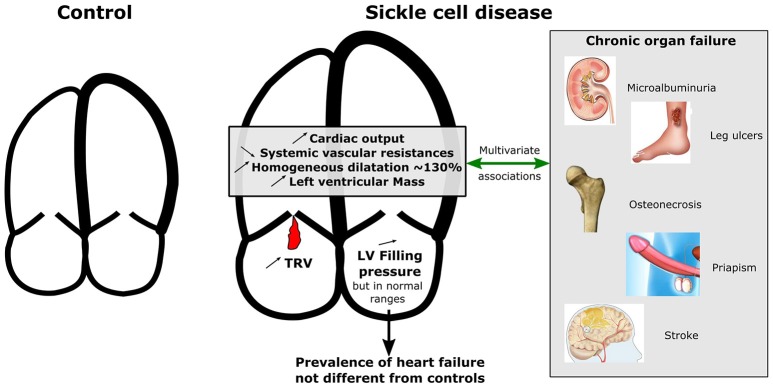
Graphical comparison for cardiac characteristics between SCD patients and controls and multivariate associations with chronic organ failure. While left ventricular ejection fraction did not differ between controls and patients, left and right cardiac chambers were homogeneously more dilated and hypertrophic in patients compared to controls and systemic vascular resistances were lower. Increased left ventricularmass index, cardiac dilatation, cardiac output, and decreased systemic vascular resistances were associated with a history of at least one SCD-related organ damage after adjustment for confounders. TRV, Tricuspid regurgitant velocity; LV, Left ventricle.